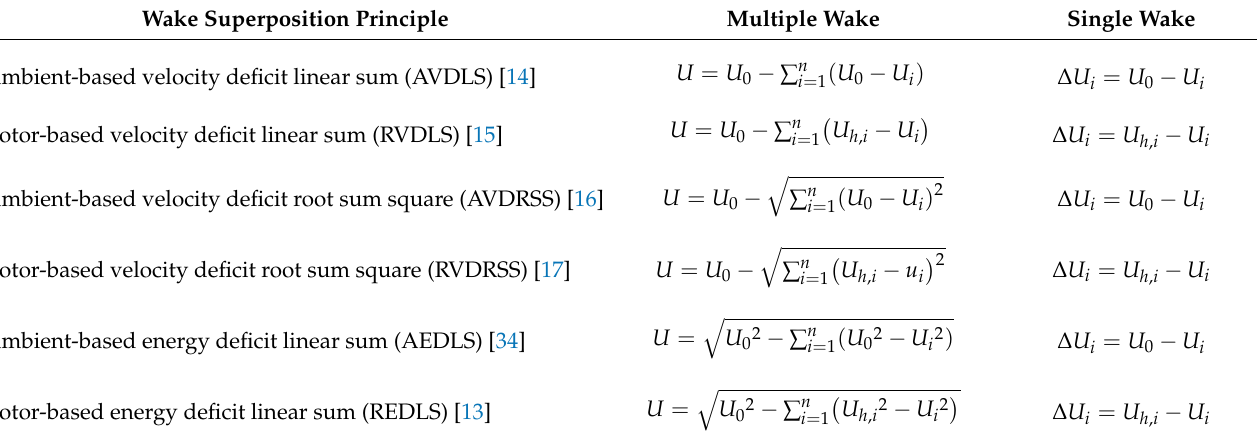
Table 5. Superposition approaches of multiple wind turbines.